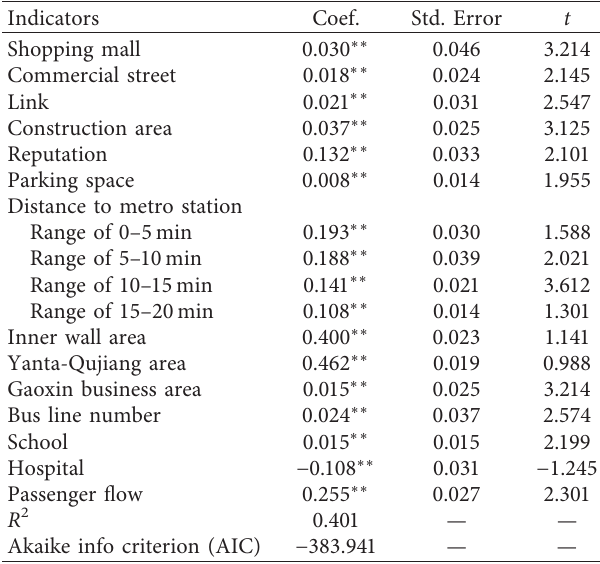
Table 9: Parameters estimation using 20-minute study range, SAR, and 900-metre threshold distance.